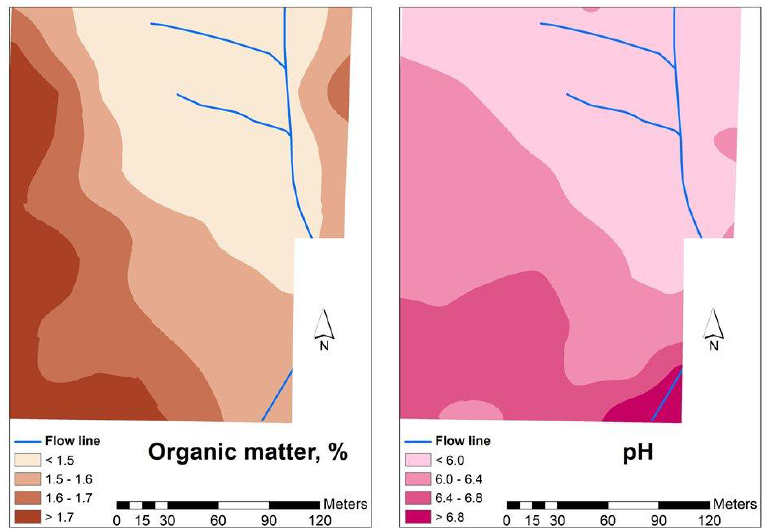
Figure 6. Organic matter content and pH in the soil of the experimental field